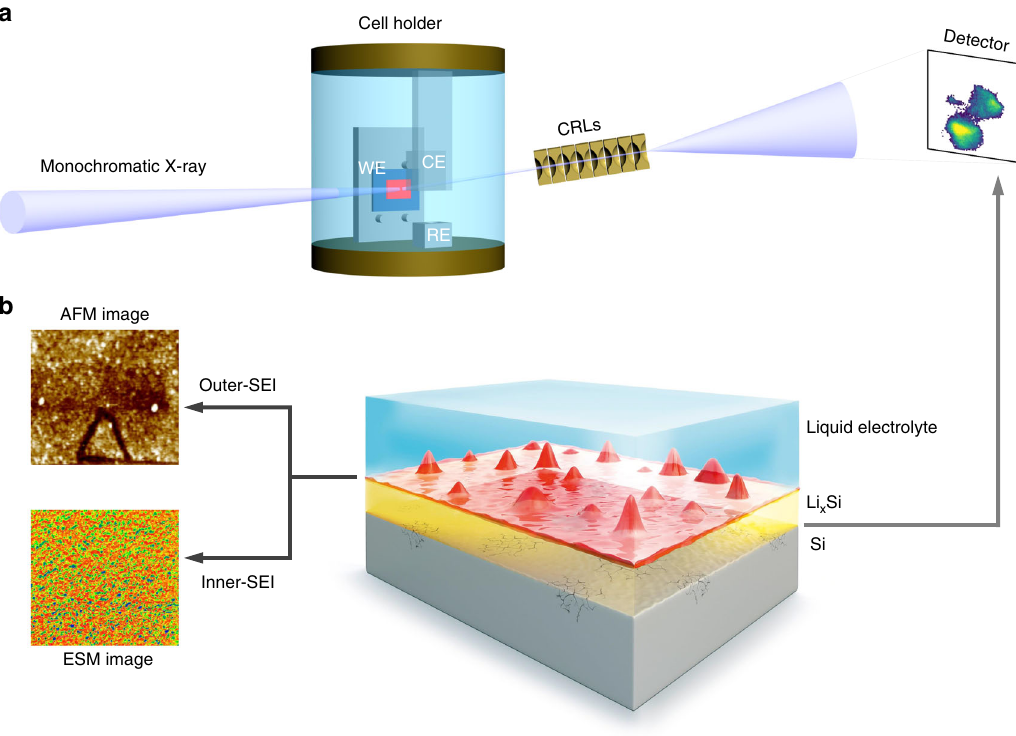
Fig. 1 Schematic illustration of the multimodal study. FFDXM working principle and operando electrochemical cell con fi guration ( a ). Single-crystal Si samples were prepared as the working electrodes (WE) and assembled in a custom-made cell with two lithium metal foils, acting as the reference (RE) and the counter electrode (CE). The cell is fi lled with 1 M LiPF 6 dissolved in ethylene carbonate/dimethyl carbonate (EC/DMC, 1:1 by volume). X-ray photons diffracted by the Si electrode are imaged by a set of compound refractive lenses (CRLs) onto an area detector. The exposure time per frame used to obtain the results in the present research is 1 s. The multilevel interfaces probed by FFDXM (Si/Li x Si) as well as the combination of AFM, ESM, and XPS (inner-/ outer-SEI) are schematically depicted in b